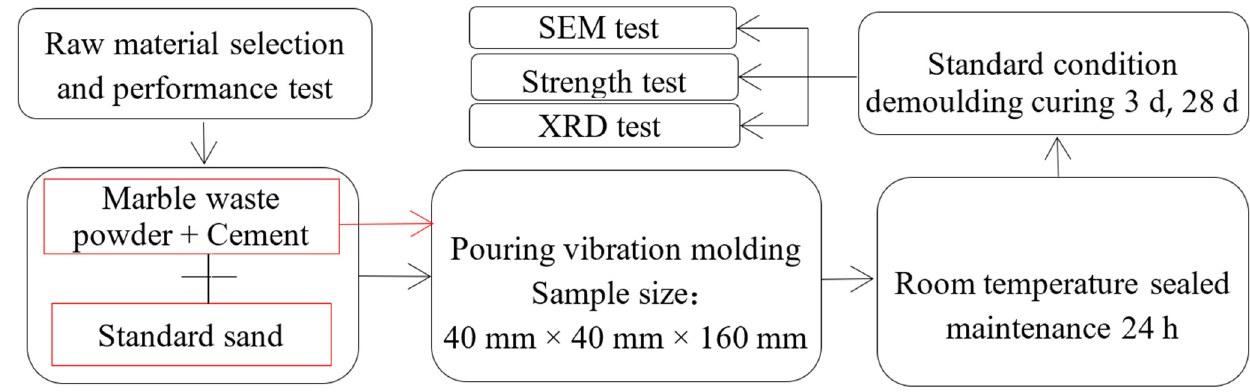
Figure 4. Test design and sample preparation process. Table 3. Test mix ratio.